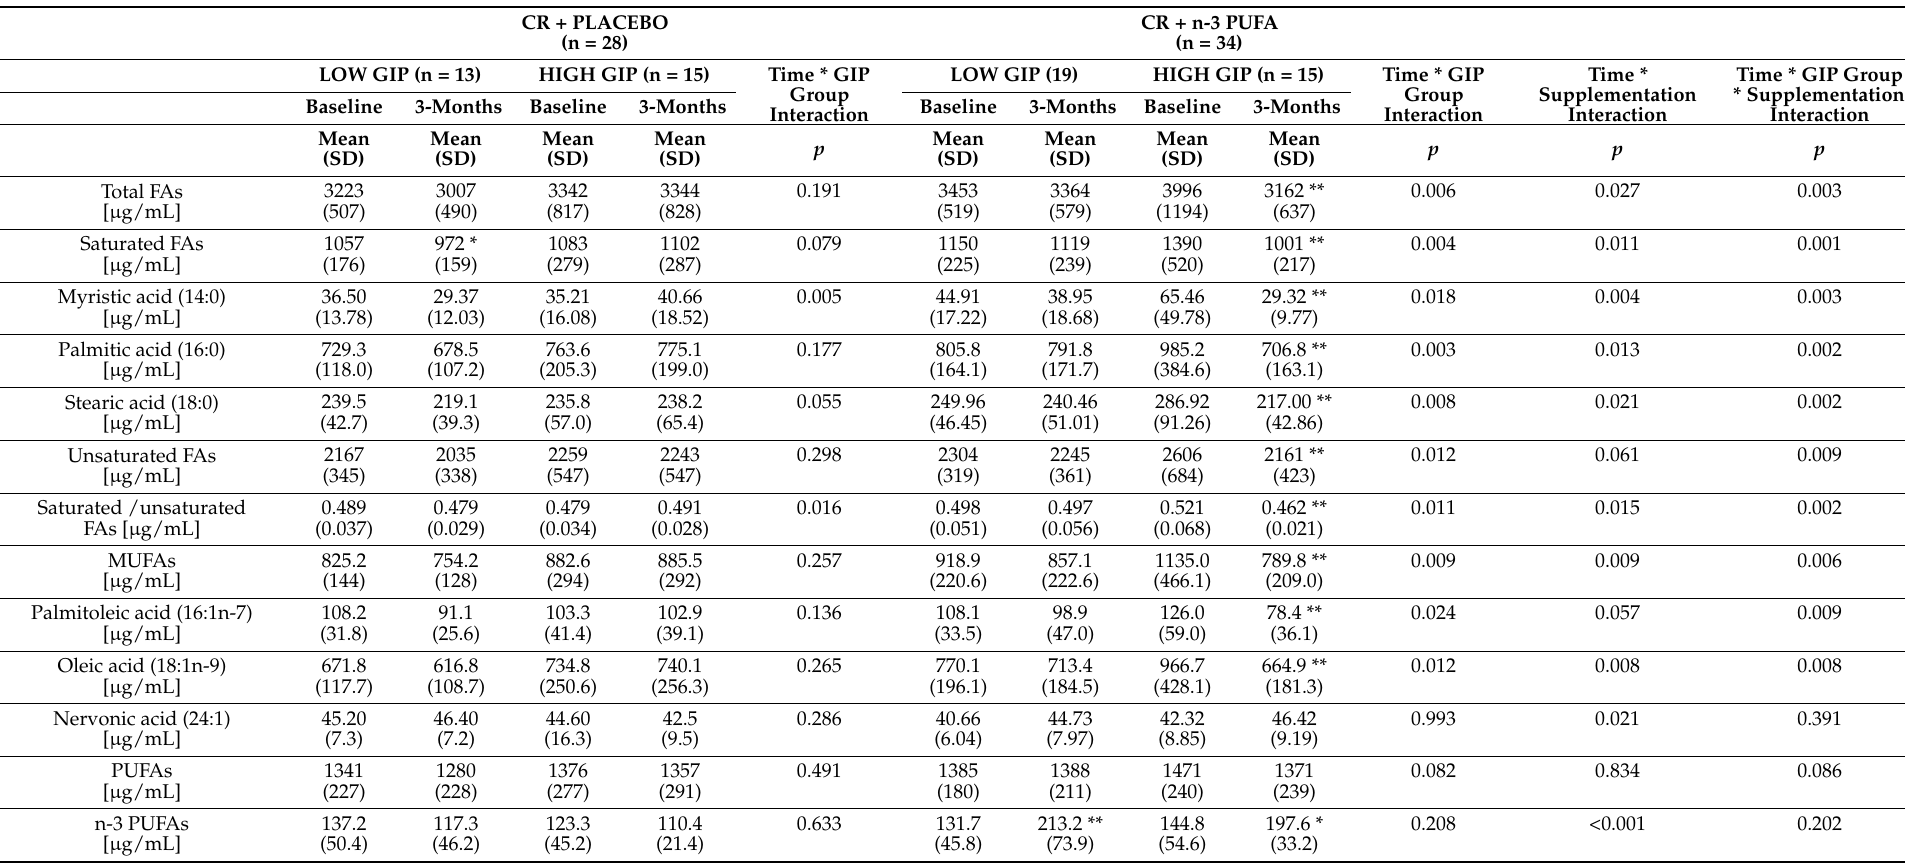
Table 5. Effect of placebo and n-3 PUFA supplementation on plasma fatty acids profile according to GIP plasma